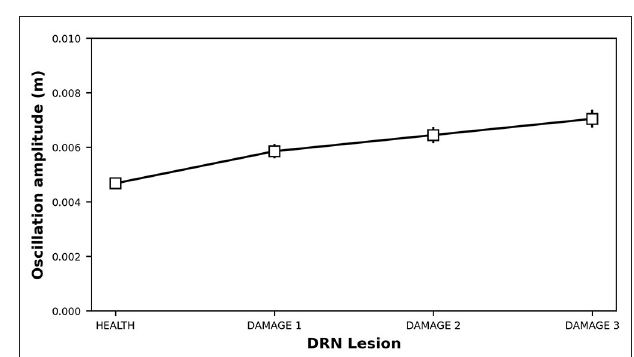
FIGURE 5 | Oscillation induced by 5-HT release impairments. DAMAGE1 = τ DRN + 40 % ; DAMAGE2 = τ DRN + 60 % ; DAMAGE3 = τ DRN + 80 %